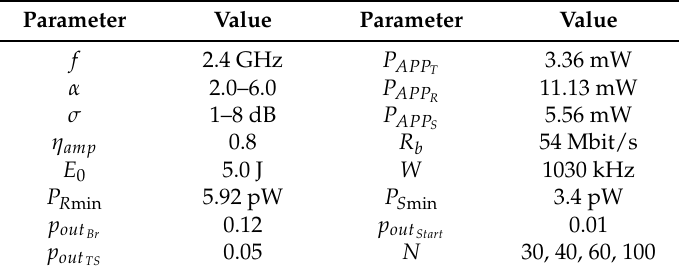
Table 2. Reference value of simulation